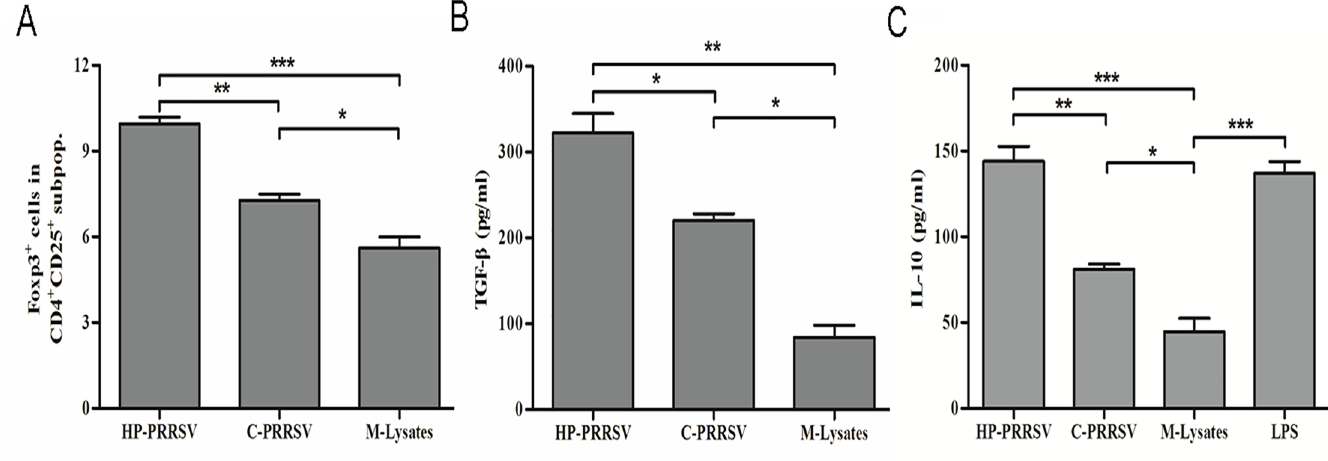
Fig 2. Effects of different PRRSV strains on Tregs induction. (A) Percentage of Foxp3 + cells in the gated CD4 + CD25 + subpopulations of HP-PRRSV and C-PRRSV. (B) Concentrations of TGF- β in the supernatants of 3-day co-cultures. (C) Concentrations of IL-10 in supernatants of 3-day co-cultures. Data came from three independent experiments. Data analysis was done using one-way ANOVA and significant differences are shown ( * P < 0.05, ** P < 0.01 and *** P <